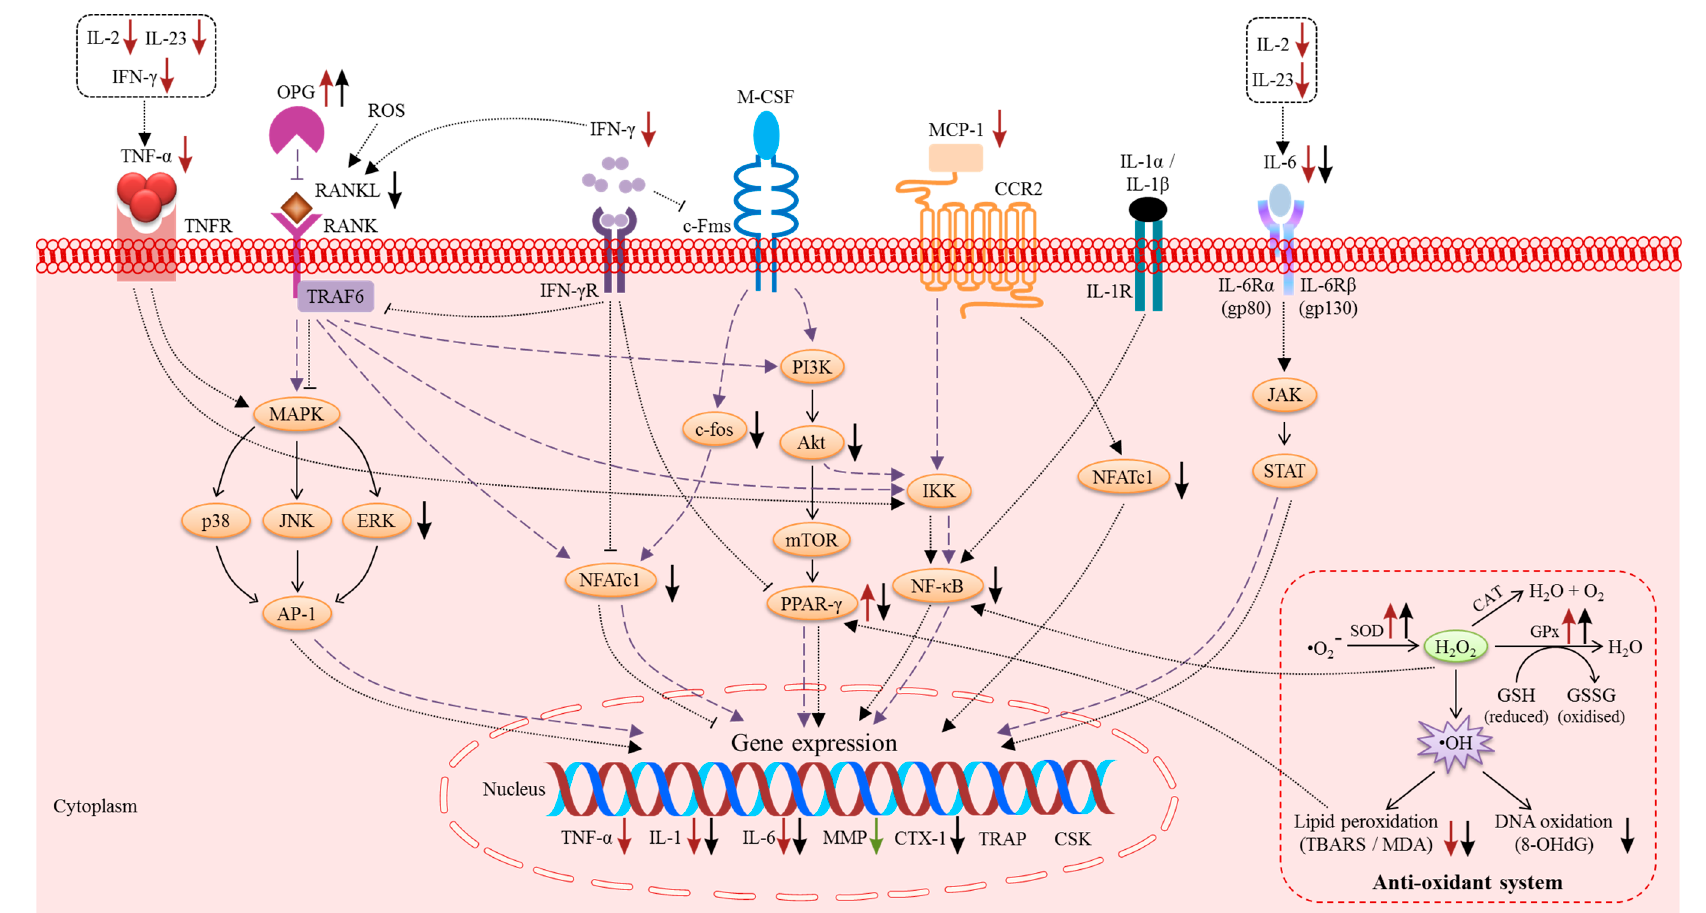
Figure 2. The signalling in osteoclasts for the regulation of bone metabolism. Under normal conditions, several essential signalling events can be activated to initiate the activity of bone resorption (indicated by the purple dotted line, — — ). Inflammation and oxidative stress further activate bone resorption via several pathways (indicated by the black dotted line, ······ ). The effects of TF (red arrows), T3 (black arrows) as well as high doses of TF and T3 (green arrows) are indicated.